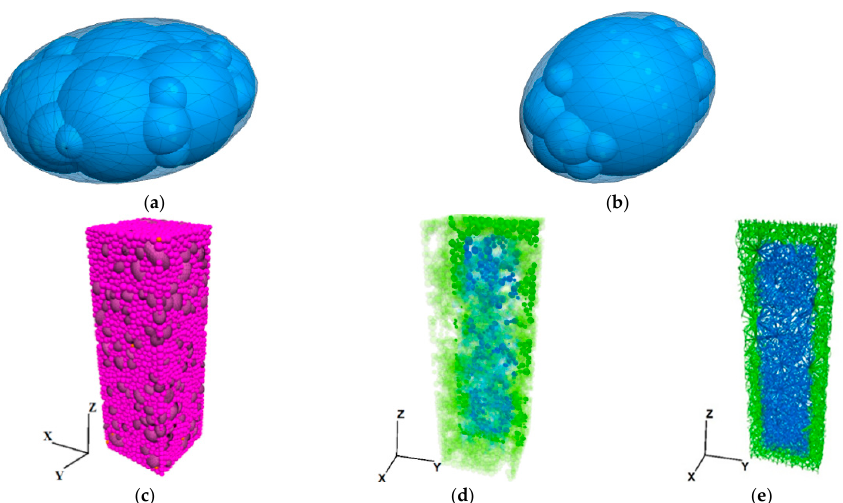
Figure 7. Model regional grouping diagram and numerical model of freezing–thawing cycle. ( a ) Oblate sphere coarse aggregate; ( b ) Ellipsoid coarse aggregate; ( c ) Freezing–thawing concrete model; ( d ) Regional grouping diagram of specimens model; € Grouping diagram of contact attribute area of specimen.